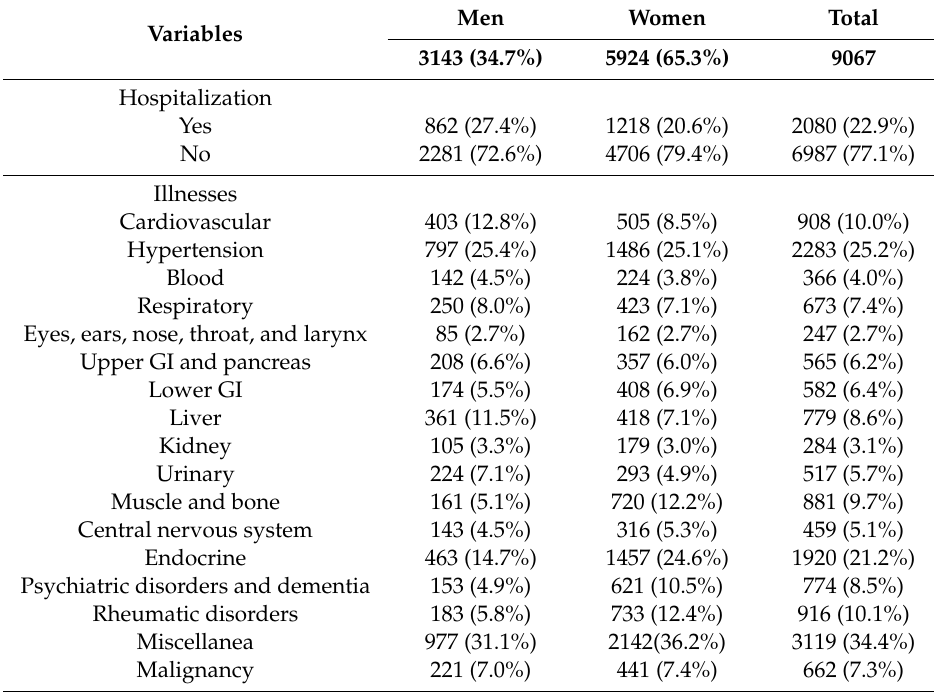
Table 2. Clinical features of study participants.